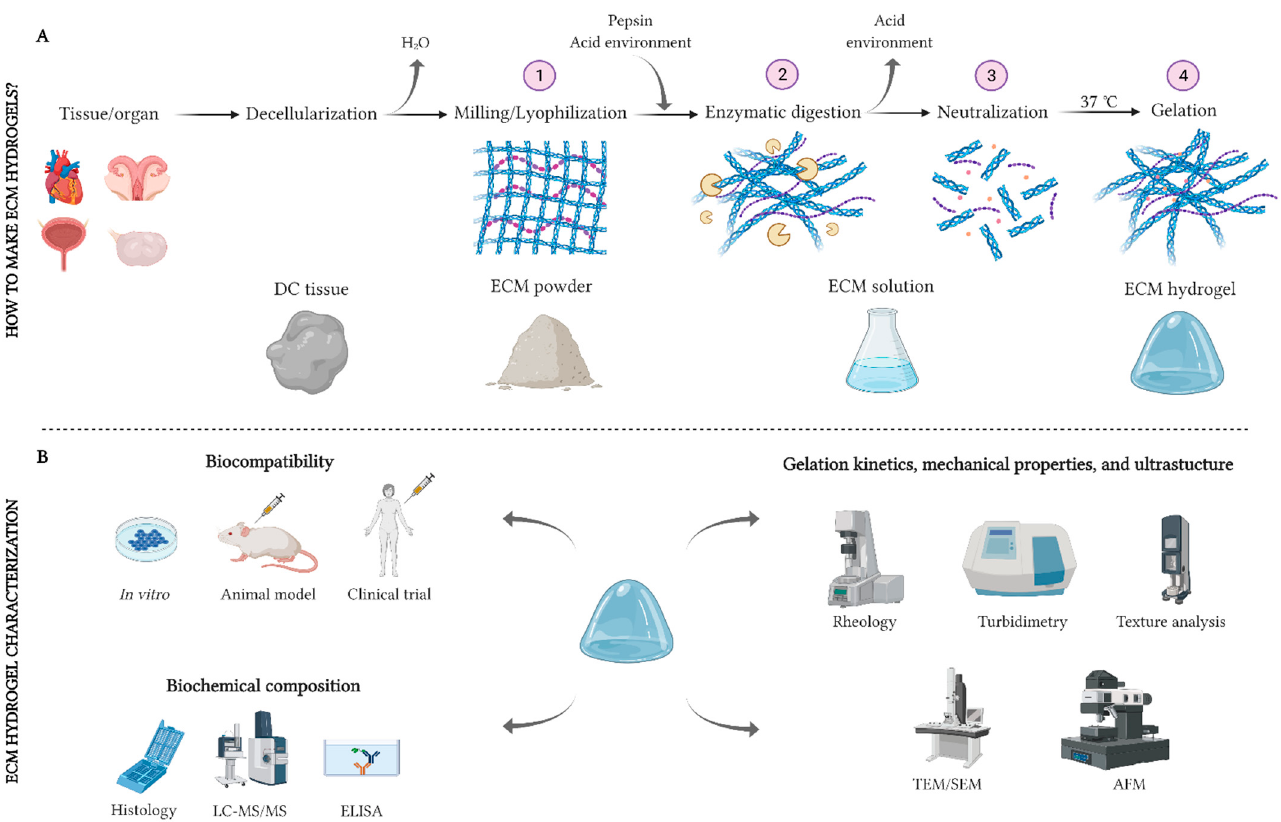
Figure 1. Schemas for generating and characterizing an ECM hydrogel. ( A ): The procedure for decellularizing, solubilizing, and gelling a native ECM. ( B ): Main techniques for the biological, biochemical, and physicomechanical characterization of ECM hydrogels. AFM: atomic force microscope; ECM: extracellular matrix; ELISA: enzyme-linked immunosorbent assay; LC-MS/MS: liquid chromatography tandem-mass spectrometry; SEM: scanning electron microscope; TEM: transmission electron microscope. Section A is adapted with permission from López-Martínez et al. 2021 [40]. Created with Biorender.com.